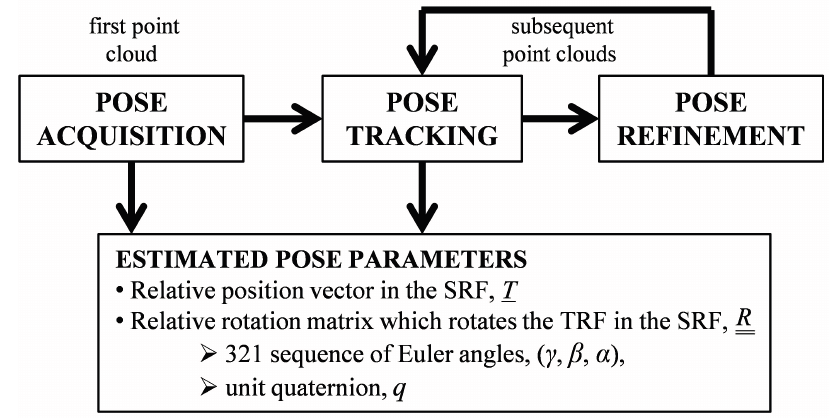
Figure 1. Logical scheme of the process for pose determination of a moving